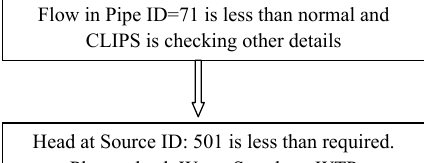
Figure 19. Advice / Suggestion / Warning issued by CLIPS. Figure 18. Variation of Total Energy and total head loss. Fig. 19. Advice/Suggestion/Warning issued by CLIPS. Fig. 20. Messages received for addressing consumer complaint Fig. 18. Variation of Total Energy and total head loss